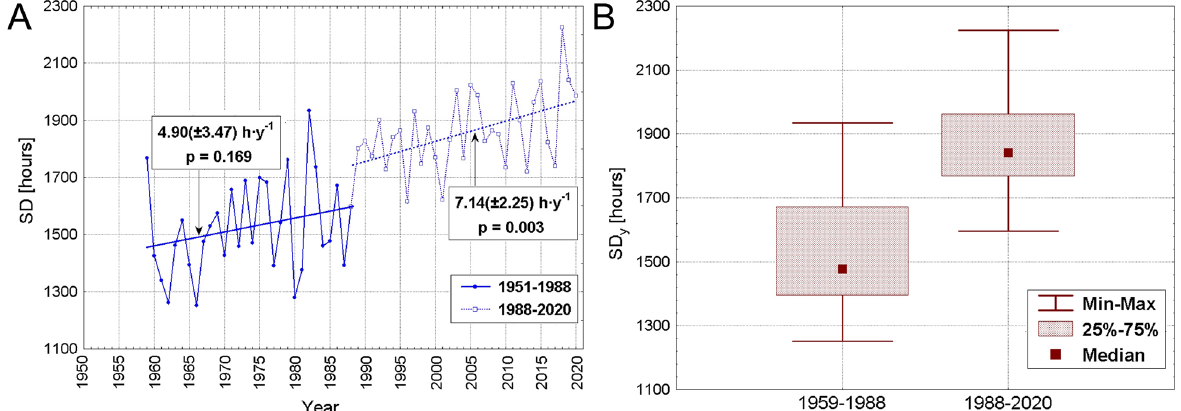
Fig. 4. The annual SD with marked values of trends and their statistical significance ( p ) (A), and its variability y ranges (B) in Poznań in sub-periods 1959–1988 and 1988–2020. SD, sunshine